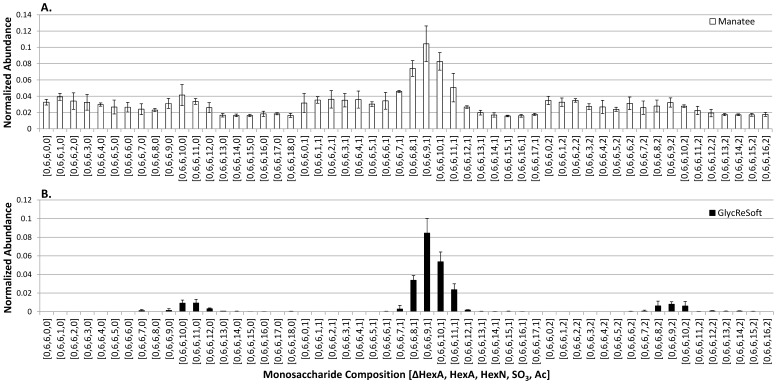
Comparison of Manatee (A) and GlycReSoft (B) for compositional profiling of HS oligosaccharides.HS oligosaccharides were prepared as described in the methods section and analyzed using negative polarity HILIC LC/MS. The histograms were normalized relative to the average of the 10 most abundant compositions. Compound compositions are given as [ΔHexA, HexA, HexN, SO3, Ac].